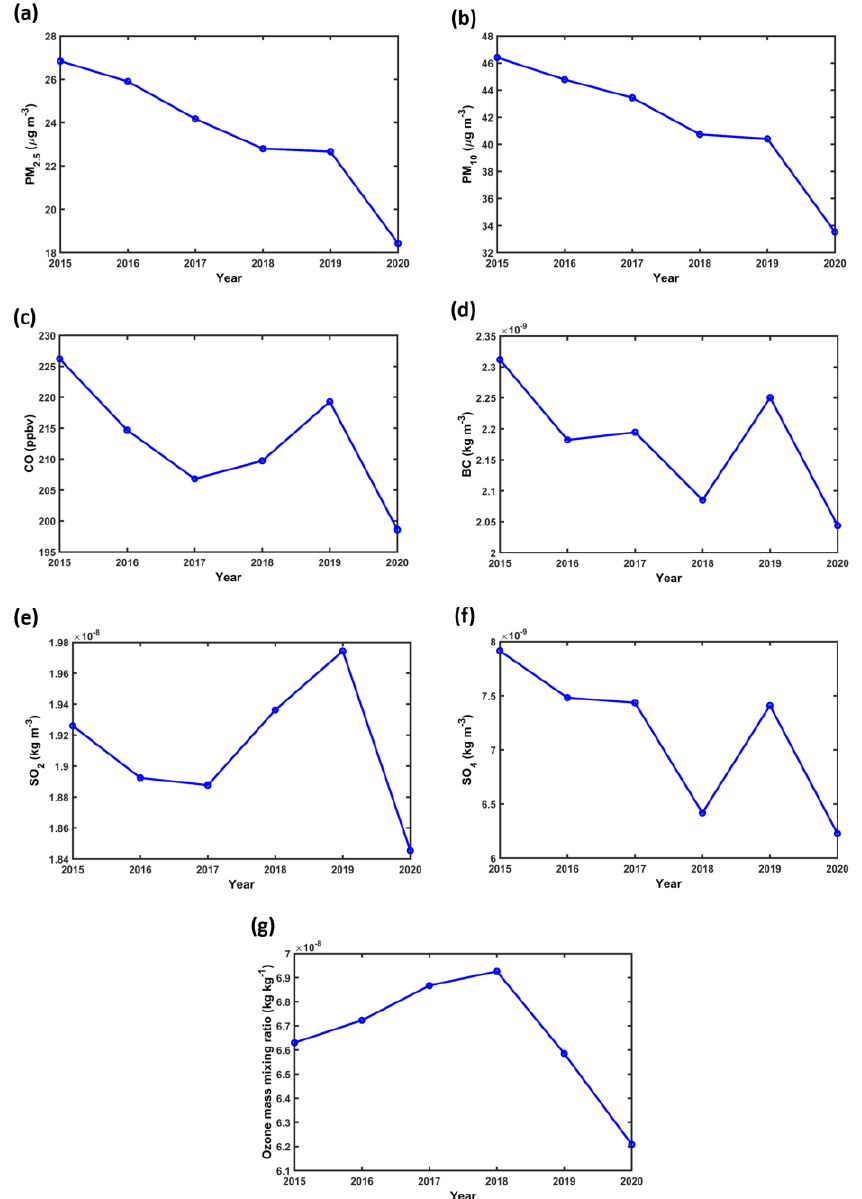
Figure 8. Mean annual distribution of particulate matter (PM) and other pollutants (2015 – 2020). ( a ) PM 2.5 , ( b ) PM 10 , ( c ) CO, ( d ) BC, ( e ) SO 2 , ( f ) SO 4 , and ( g ) ozone mass mixing ratio.